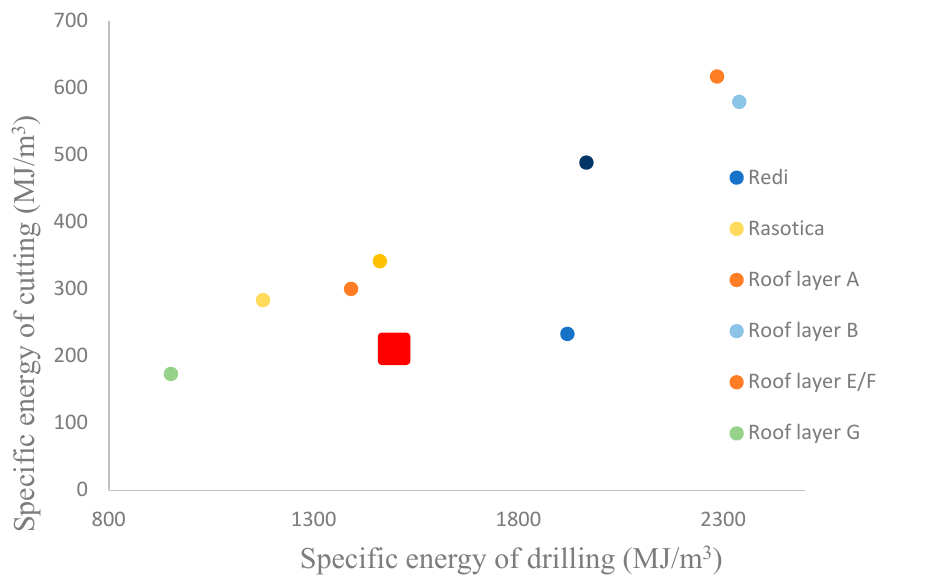
Table 5. Comparison of measuring systems.